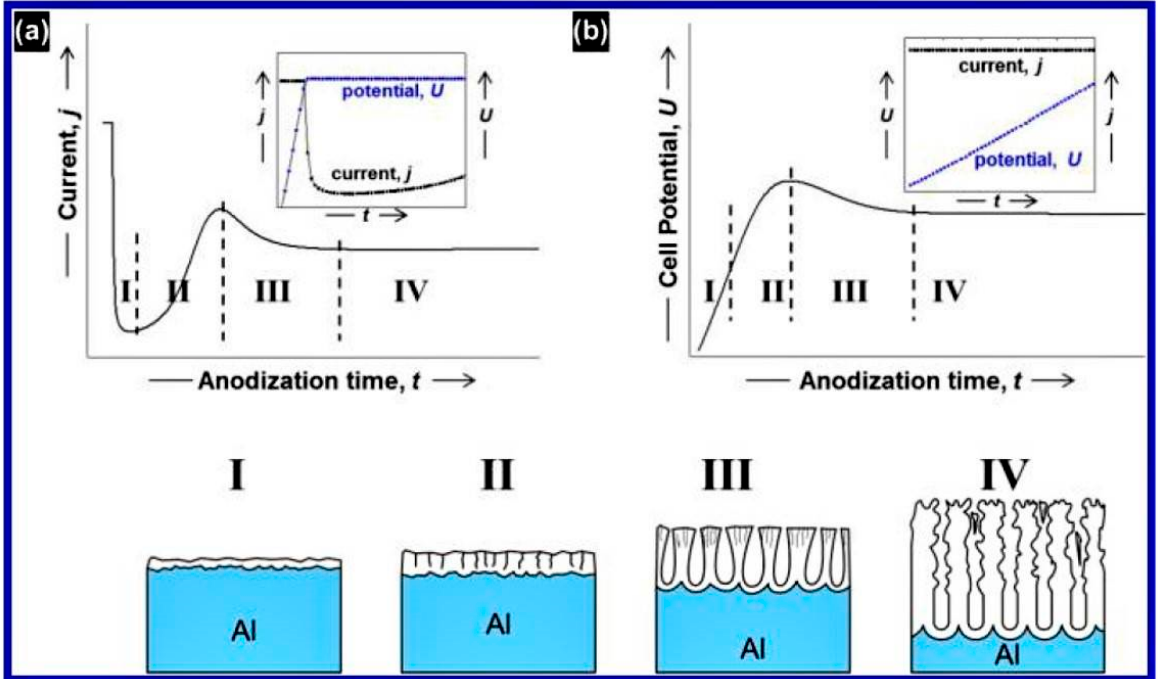
Figure 7. Schematic representations of the kinetics of the porous oxide growth in NAA showing distinct pore-growth stages under ( a ) potentiostatic and ( b ) galvanostatic conditions. Reprinted with permission from Woo Lee and Sang-Joon Park, Chemical reviews 114 (15), 7487 (2014). Copyright 2014 American Chemical Society [4].